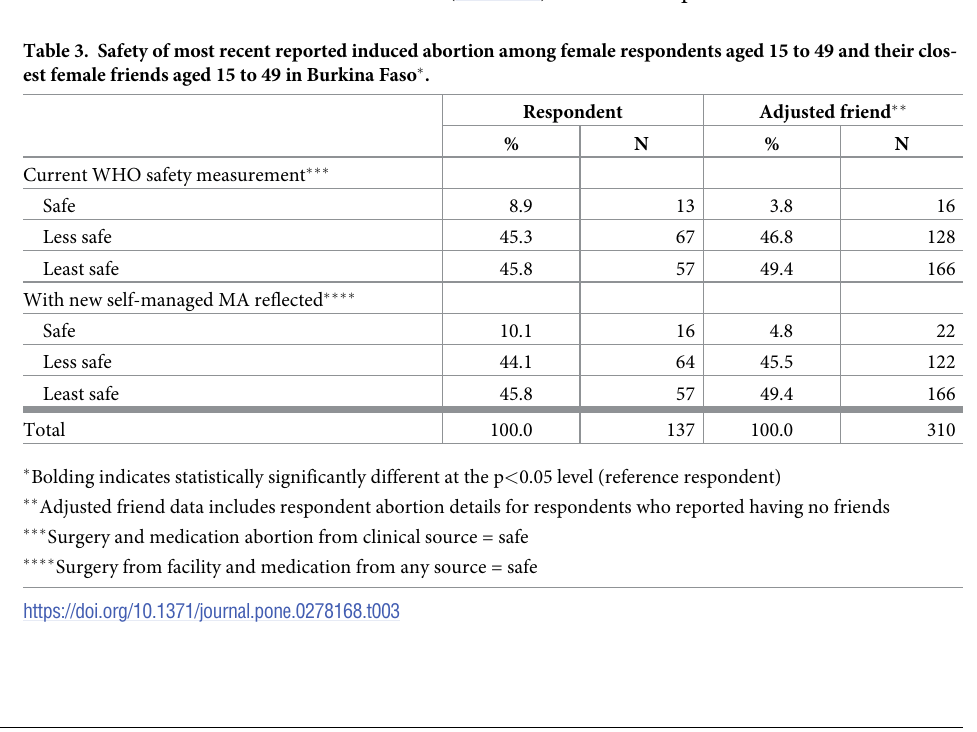
Using the abortion safety definition that is most aligned with current WHO safe abortion guidelines (i.e., self-managed medication abortion categorized as safe), we present the percent of abortions considered unsafe (less safe and least safe combined) for respondents and friends by background characteristics in Fig 2 (and S3 Table). Overall, 89.9% of respondents’ abortions and 95.2% of friend abortions were unsafe (S3 Table). For both respondents and friends, the Table 3. Safety of most recent reported induced abortion among female respondents aged 15 to 49 and their clos- est female friends aged 15 to 49 in Burkina Faso � . Respondent